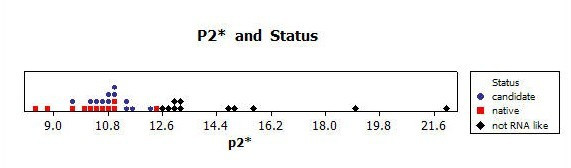
Dot plot for P2*
 MathType@MTEF@5@5@+=feaafiart1ev1aaatCvAUfKttLearuWrP9MDH5MBPbIqV92AaeXatLxBI9gBaebbnrfifHhDYfgasaacH8akY=wiFfYdH8Gipec8Eeeu0xXdbba9frFj0=OqFfea0dXdd9vqai=hGuQ8kuc9pgc9s8qqaq=dirpe0xb9q8qiLsFr0=vr0=vr0dc8meaabaqaciaacaGaaeqabaqabeGadaaakeaacqWGqbaudaqhaaWcbaGaeGOmaidabaGaeiOkaOcaaaaa@2FD0@.